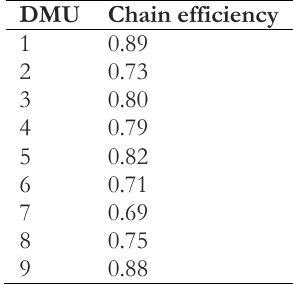
Table 4. Calculation of chain efficiency score with the proposed